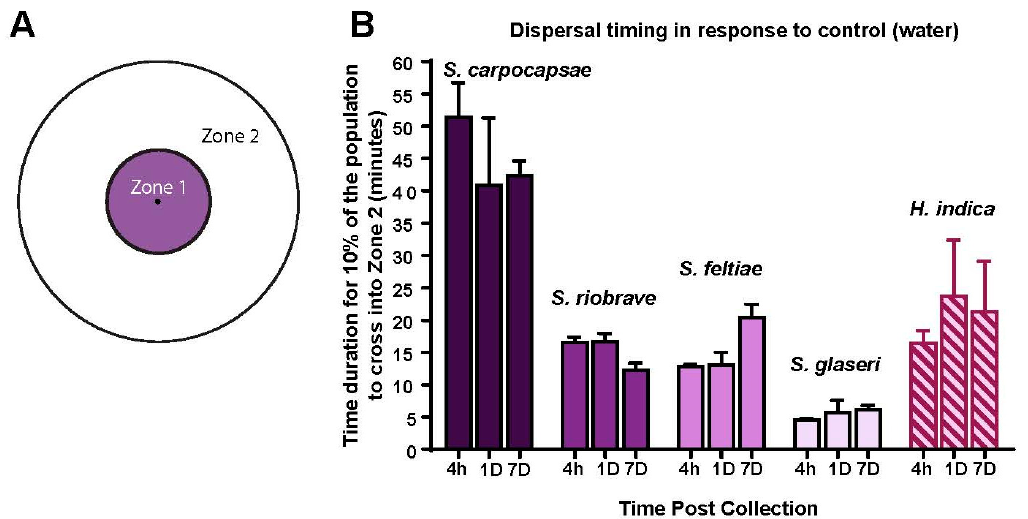
Figure 3. Timing assay information. ( A ) Template for timing and dispersal assays, the black dot in the center of zone 1 represents the initial placement of nematodes. ( B ) Results of timing assays for each species and time post-collection. Along the X-axis the time post-collection is listed: 4 h, 1 day and 7 days. Evaluations for each species and time point post-collection were conducted with photography (see methods) to determine how long it took for the IJs to cross completely over into zone 2 from zone 1 (shown in panel A). Mean is shown and error bars represent SEM; statistical analysis used Repeated Measure (RM) two-way ANOVA , and Tukey’s multiple comparisons test , but no statistical differences were found within each species dispersal across the time post-collection.